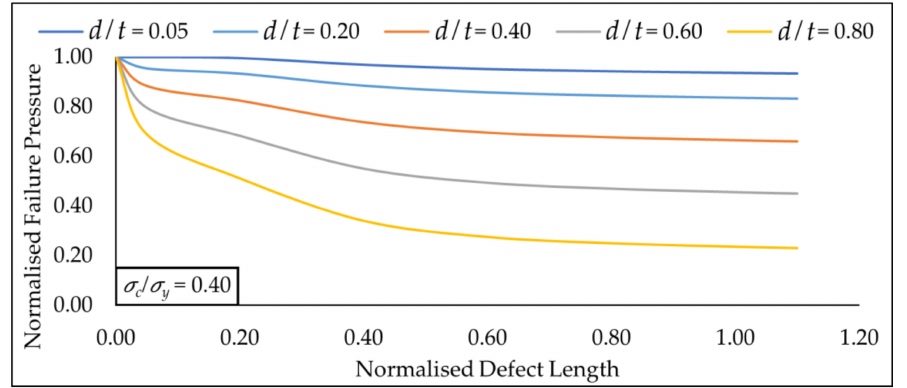
Figure 18. Normalized failure pressure predictions of the new assessment method against vari- ous normalized defect length for multiple normalised defect depths at constant normalized axial compressive stress of 0.40.